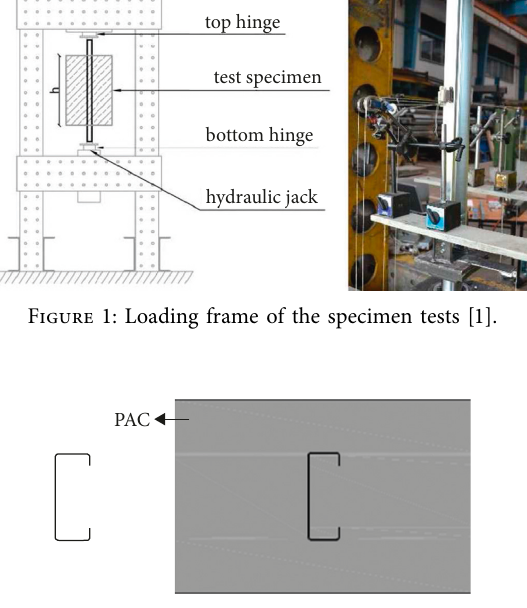
Figure 2: Cross-section of unbraced (left) and PAC braced (right) specimens